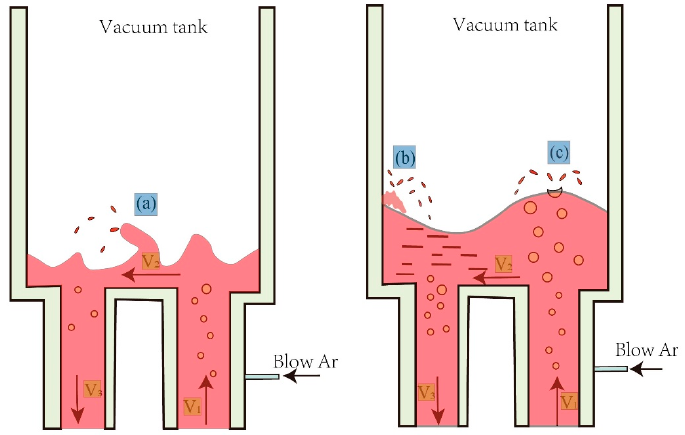
Figure 12. Mechanism of RH droplet splashing under different conditions